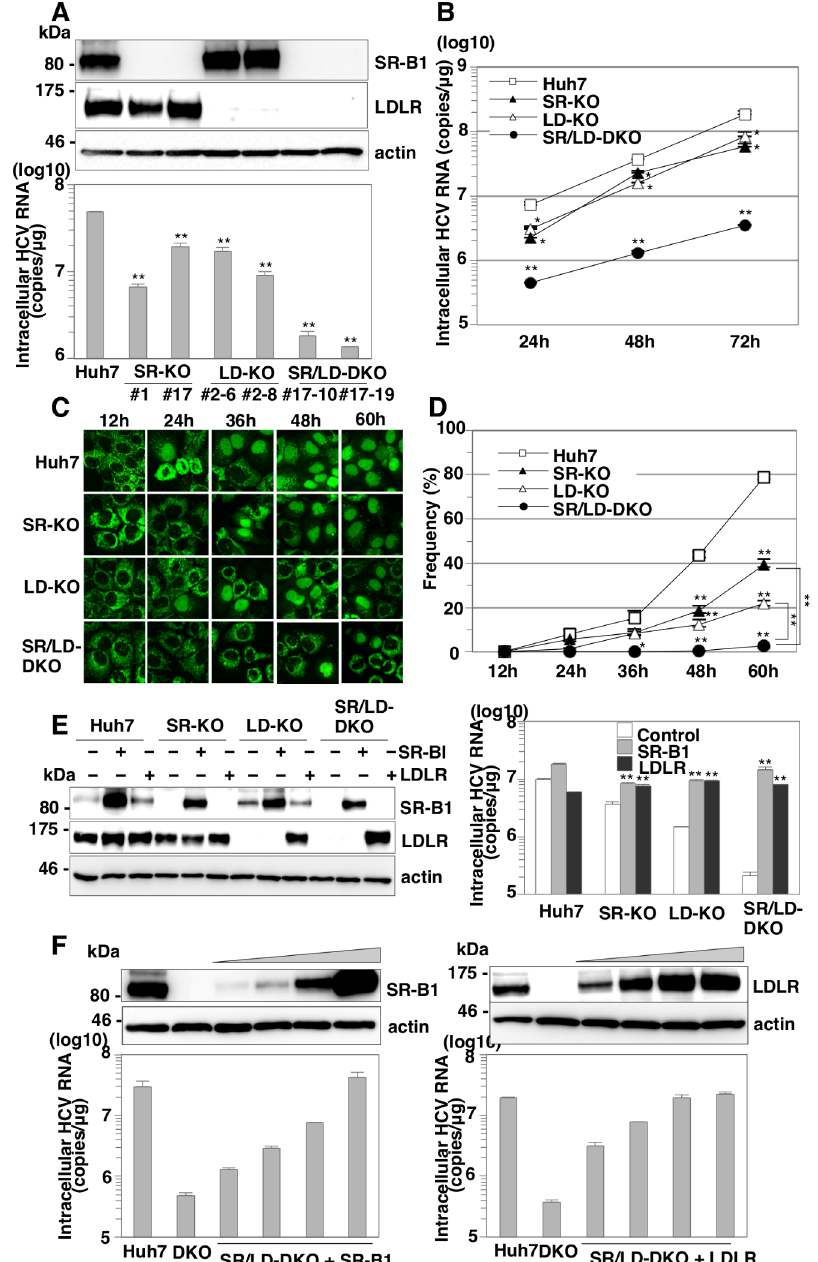
Fig 3. SR-B1 and LDLR have a redundant role in HCV entry. (A) Expressions of SR-B1 and LDLR in parental, SR-KO, LD-KO and SR/LD-DKO Huh7 cells were determined by immunoblotting analysis (upper panel). Cells were infected with HCVcc at an MOI of 1, and intracellular HCV RNA levels were determined at 24 h post-infection by qRT-PCR (lower panel). (B) Parental, SR-KO, LD-KO and SR/LD-DKO Huh7 cells were infected with HCVcc at an MOI of 1, and intracellular HCV RNA levels were determined at 24, 48 and 72 h post-infection by qRT-PCR. (C, D) Fluorescence localizations in parental, SR-KO, LD-KO and SR/LD-KO Huh7 cells were observed with a confocal microscope, upon infection with HCVcc at an MOI of 1 at 12, 24, 36, 48 and 60 h post-infection. The frequency is shown as the ratio of infected cells to total cells. (E) SR-B1 and LDLR were exogenously expressed in parental, SR-KO, LD-KO and SR/LD-DKO Huh7 cells by infection with lentiviral vectors. Expressions of SR-B1 and LDLR in these cells were determined by immunoblotting analysis (left panel). Cells were infected with HCVcc at an MOI of 1 and intracellular HCV RNA levels were determined at 24 h post-infection by qRT-PCR (right panel). (F) SR-B1 and LDLR were exogenously